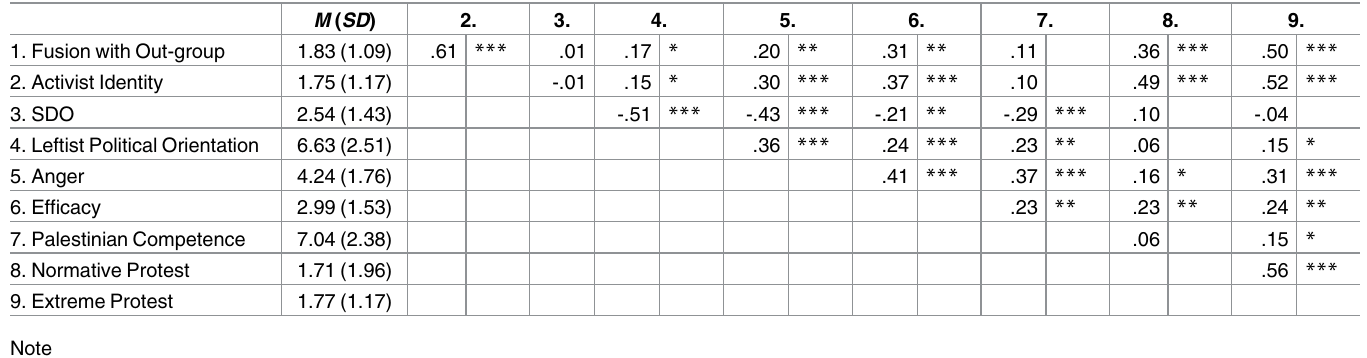
Table 1. Means, Standard Deviations and Correlations between variables in Study 1 are